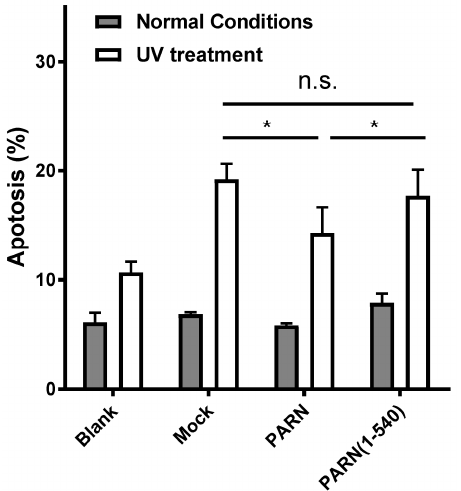
Figure 4. Effect of exogenously expressed PARN on cell apoptosis induced by UV treatment. Percentages of apoptotic HEK-293T cells were analyzed by flow cytometry, as seen in Figure S4. Data are presented as mean ± SD calculated from at least three independent experiments. * p < 0.05; n.s., not significant.